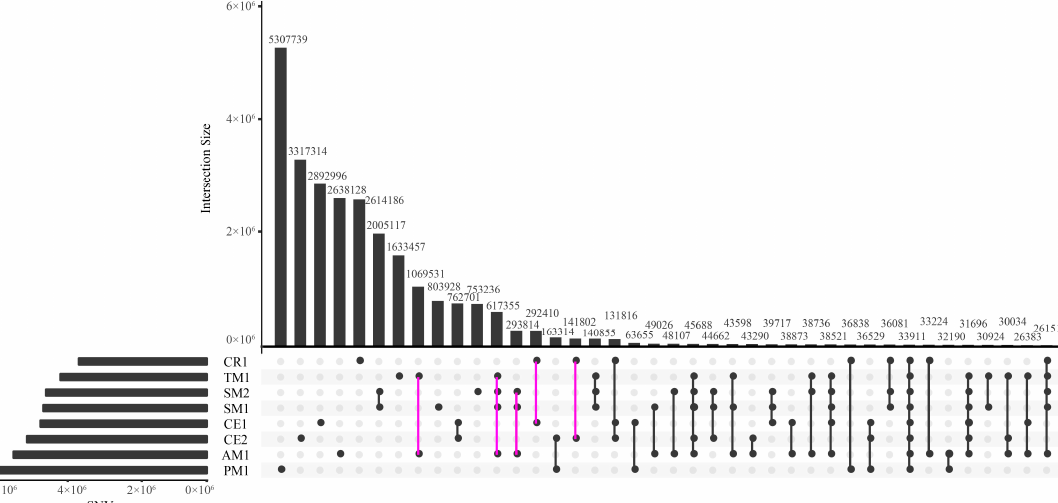
Figure 1. UpSetR plot illustrating the numbers of SNVs shared by different pairs or sets of macaques. Only the first twenty sets are displayed. Intersection Size on the y-axis represents the number of shared SNVs in the pair or set of macaques showed on x-axis.